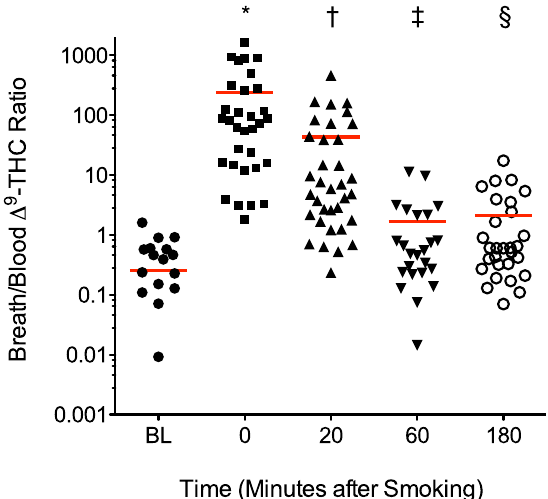
Figure 3. Breath/blood ∆ 9 -THC ratios. Red bars indicate mean values. N = 29 (pre-smoking baseline; BL); N = 32 (immediately after smoking; 0 min); N = 35 (20 min post-smoking); N = 24 (60 min post-smoking); N = 31 (180 min post-smoking). Zero values (13 at BL and 2 at 180 min) could not be shown (logarithmic scale). Due to assay quantification limits, three values (two immediately after smoking and one at 60 min post-smoking) were excluded. *( p = 0.0015), † ( p = 0.0108), ‡ ( p = 0.0107), § ( p = 0.0091) compared to BL (two-tailed t-test with Bonferroni’s adjustment for multiple comparisons; α =